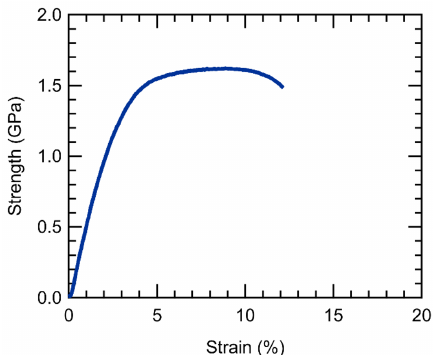
Figure 5. Tensile behavior of electrodeposited bulk nanocrystalline Fe-Ni alloys with Ni content of 44